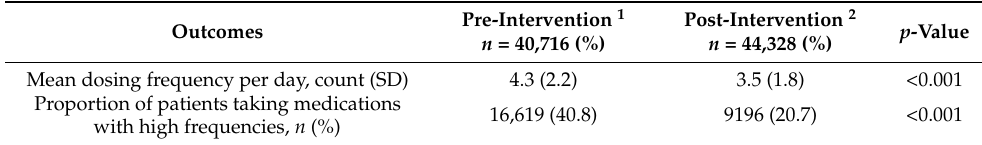
Table 4. Medication regimen outcomes in the pre- and post-intervention periods.